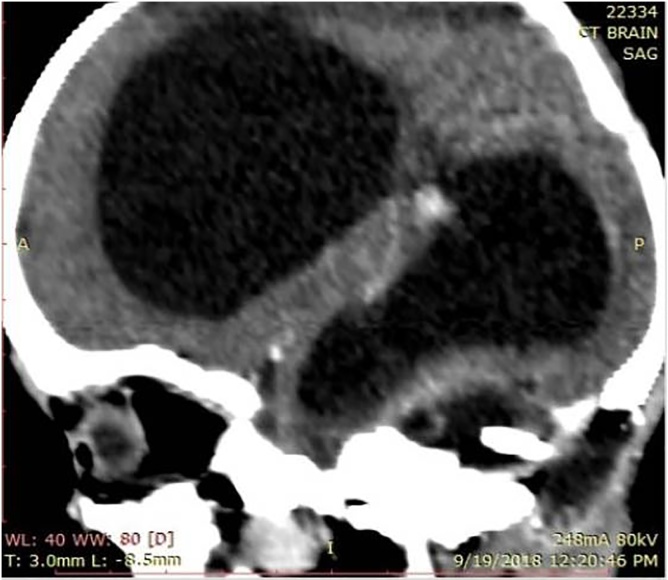
Postoperative CT scan, demonstrating the entry of the other end of the tube into the cisterna magna.